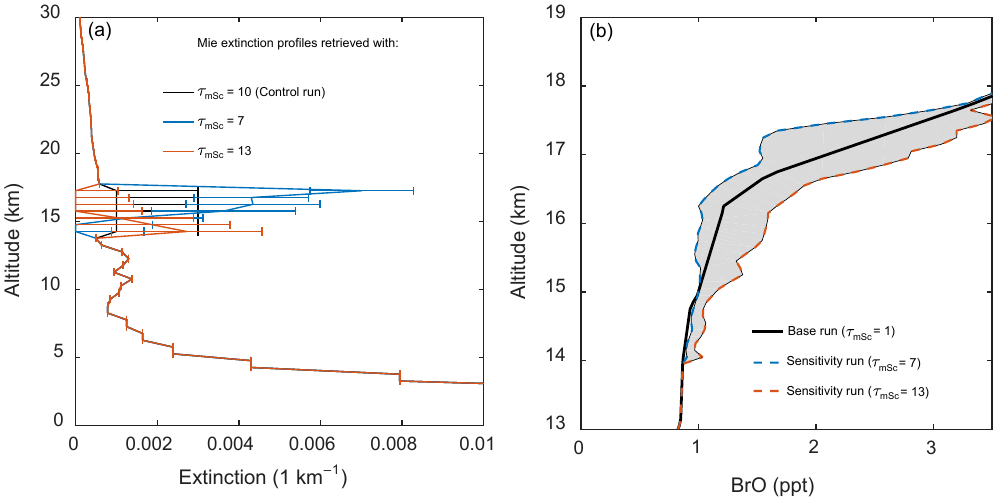
Figure 8. Theoretical study of the sensitivity of the aerosol and BrO optimal estimation retrieval on low clouds. The left panel shows the theoretical retrieval of an aerosol extinction profile from a theoretically calculated O 4 vertical profile for a marine cloud with τ mSc = 10 (control run, black curve), when the optical depth of the cloud in the retrieval is assumed to be τ mSc = 7 (blue curve) and τ mSc = 13 (red curve). The right panel shows how the variation on retrieved optical depth is propagated onto the BrO profile